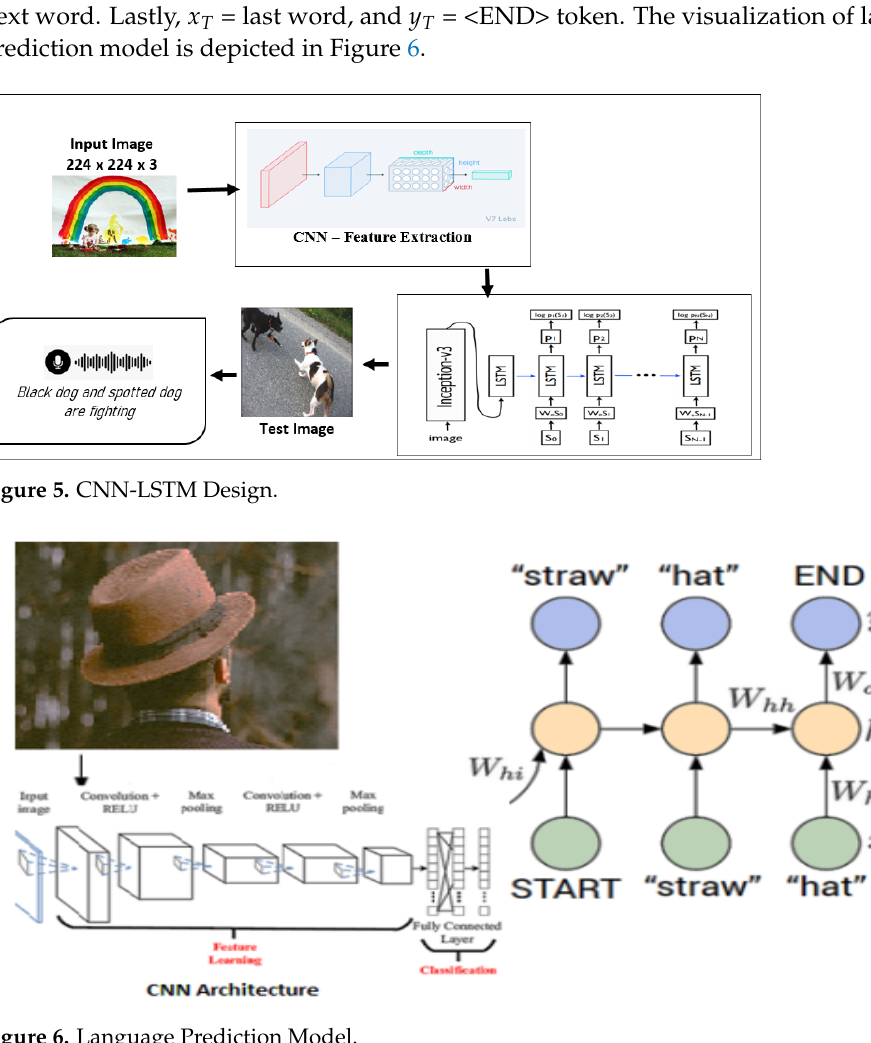
Figure 6. Language Prediction